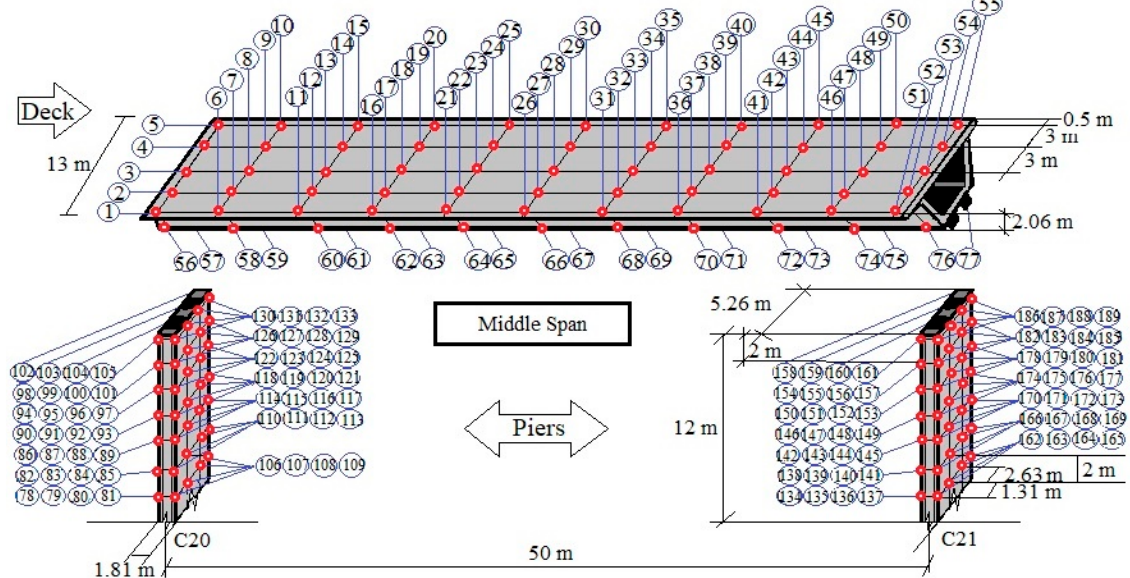
Figure 5. Numbering and division of sensor points in 1 of 40 spans of the Arosa bridge.